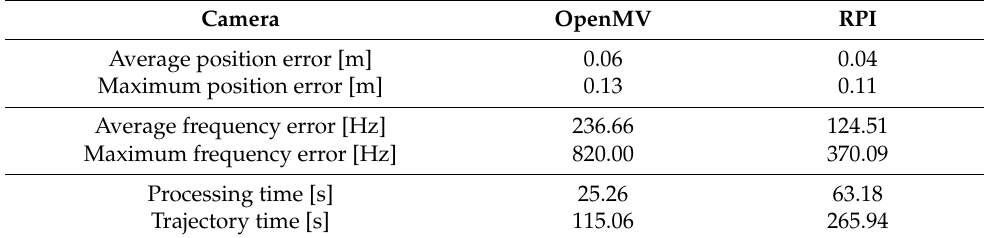
Table 7. Calibration results for different camera